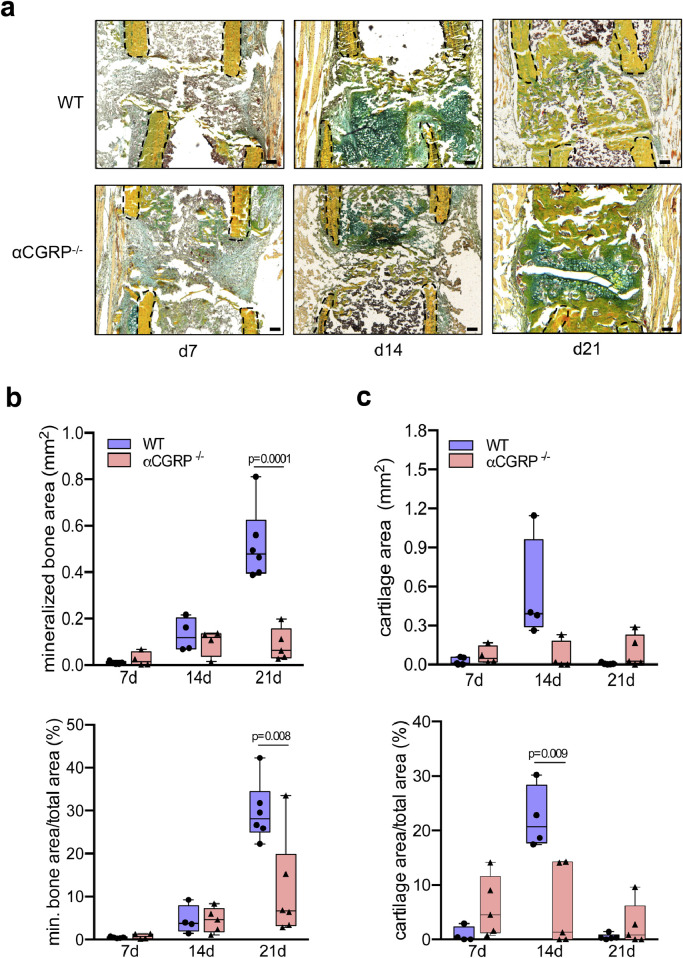
Impaired callus formation in αCGRP-deficient mice. (a) Representative callus sections (Movat Pentachrome staining) of WT and αCGRP-deficient mice at the indicated time points (yellow = mineralized bone; green = cartilage; red = muscle). Black dotted line indicates fractured bone cortices within the developing callus. (b, c) Histomorphometric quantification of static callus parameters in the same mice. Scale bars = 200 μm. n = 4–6 as indicated per group and time point. Box plots represent median with minimum and maximum whiskers. For (b) and (c), the different timepoints were evaluated independently and compared by unpaired student's t-test.